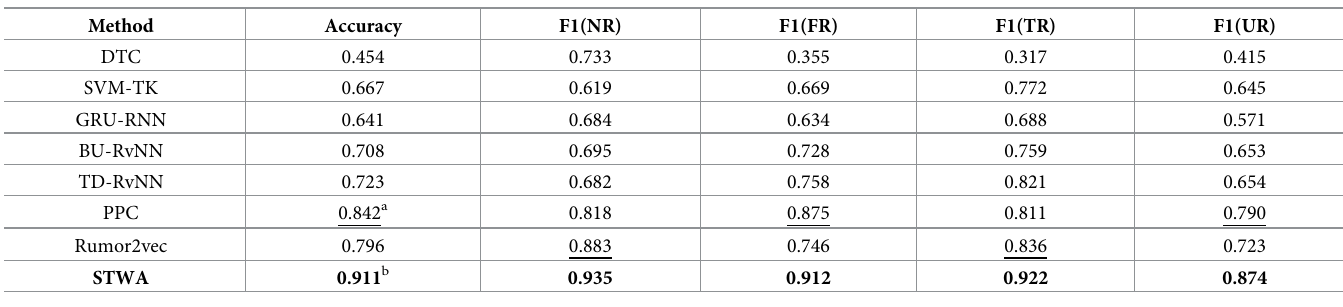
Table 2. Overall performance comparison of rumor detection on Twitter15.